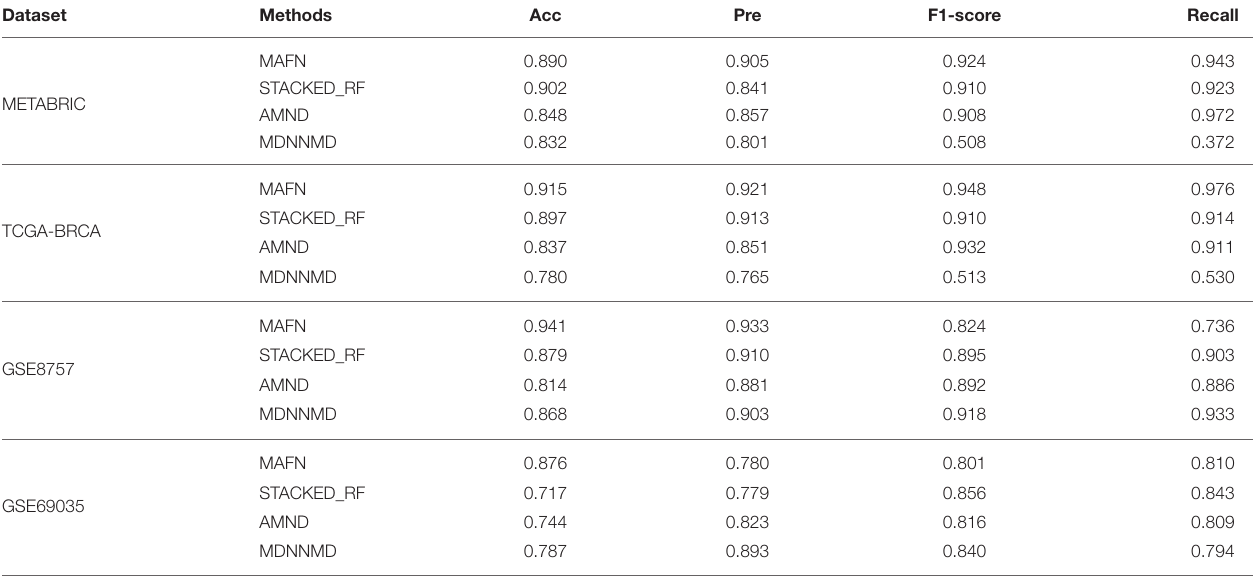
TABLE 4 | Acc, Pre, F1-score, and Recall predictive performance metrics of multimodal affinity fusion network (MAFN) and existing deep learning-based methods. Dataset